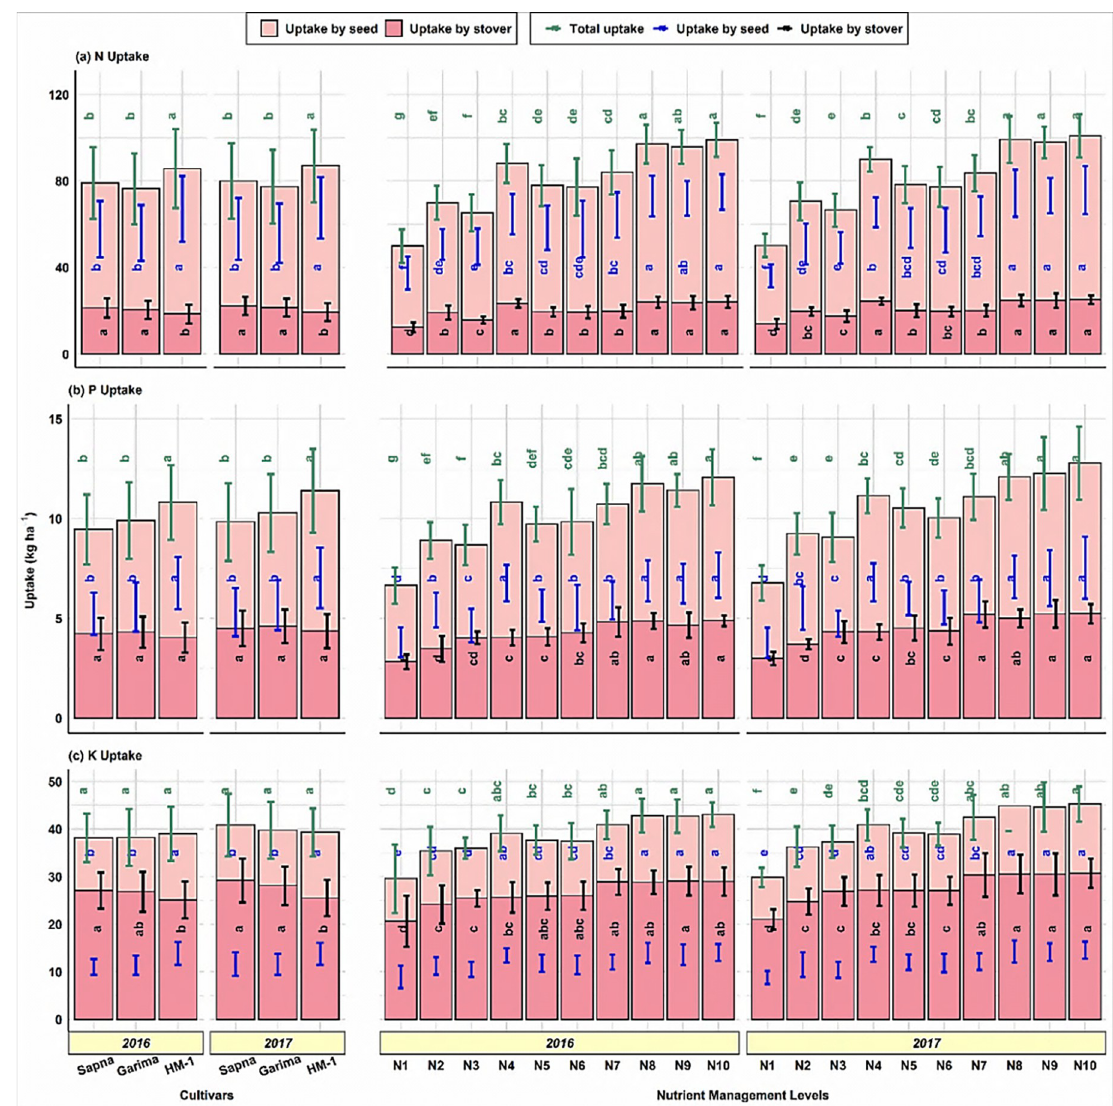
Fig 3. Nutrient uptake by seed and stover of lentil as influenced by cultivar selection and nutrient management levels.